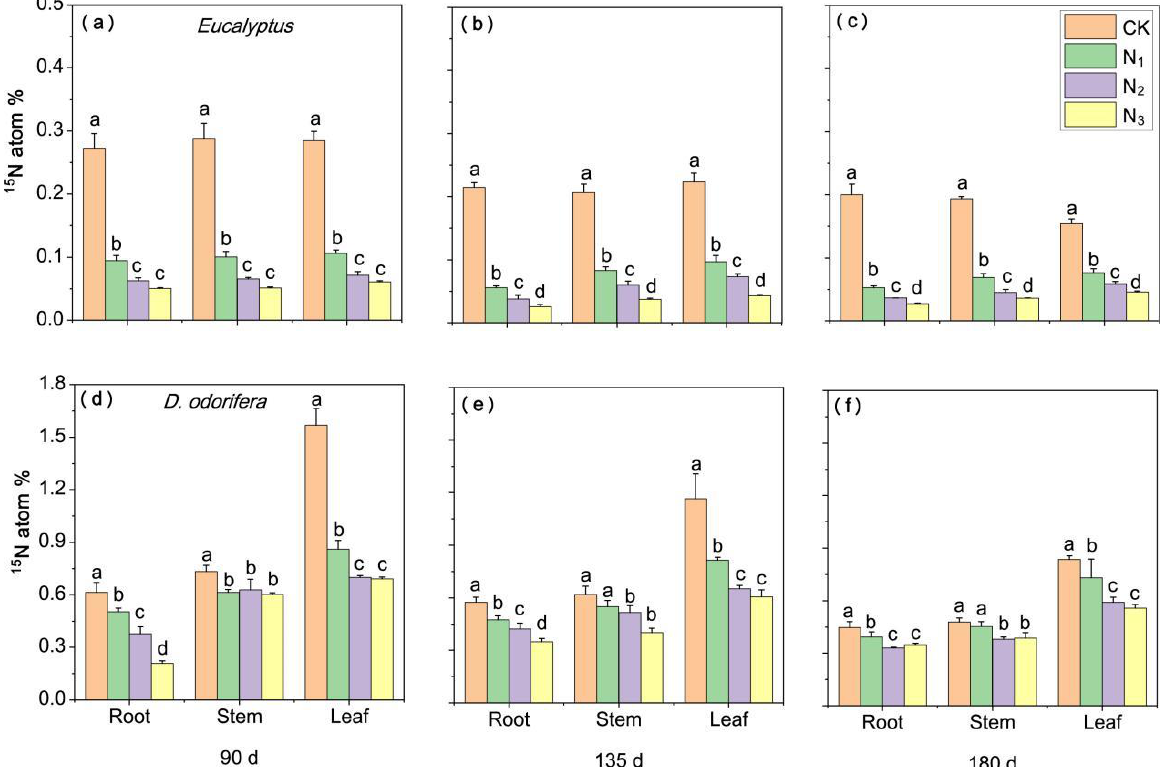
Figure 5. Atom% 15 N in excess in plant components of both species in pots where D. odorifera was labeled at different N levels, where atom% 15 N is the difference between atom% 15 N 90, 135 180 days after labeling and atom% 15 N before labeled . Panels ( a – c ) show the atom% 15 N of E. urophylla × grandis , and panels ( d – f ) show the atom% 15 N of D. odorifera . CK indicates plants without N application, and N 1 , N 2 and N 3 correspond to N fertilizer application rates of 3, 6 and 12 g urea (CO( 14 NH 2 ) 2 ) pot −1 , respectively. The different lowercase letters above the bars indicate significant differences among N treatments ( p < 0.05). Error bars indicate ± SE ( n = 4).